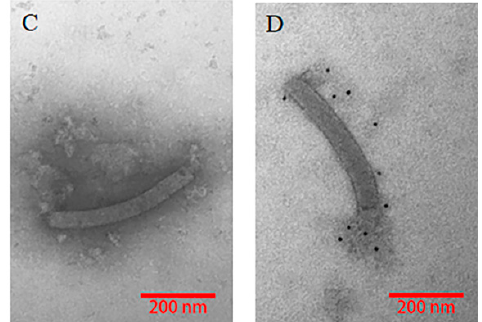
Figure 5. Immunogold electron micrographs of purified baculoviruses rvAc-P97R1P46P42-mCherry-Cap-EGFP and rvAc-dual. ( A ) rvAc-dual incubated with mCherry monoclonal antibody; ( B ) rvAc-P97R1P46P42-mChery-Cap-EGFP incubated with mCherry monoclonal antibody; ( C ) rvAc-dual incubated with EGFP monoclonal antibody; ( D ) rvAc-P97R1P46P42-mChery-Cap-EGFP incubated with EGFP monoclonal antibody. On the surface of recombinant baculovirus incubated with mCherry and EGFP monoclonal antibodies, about 10 nm diameter colloidal gold particles were clustered in the envelope region, and no colloidal gold particles were found on the wild-type baculovirus surface.